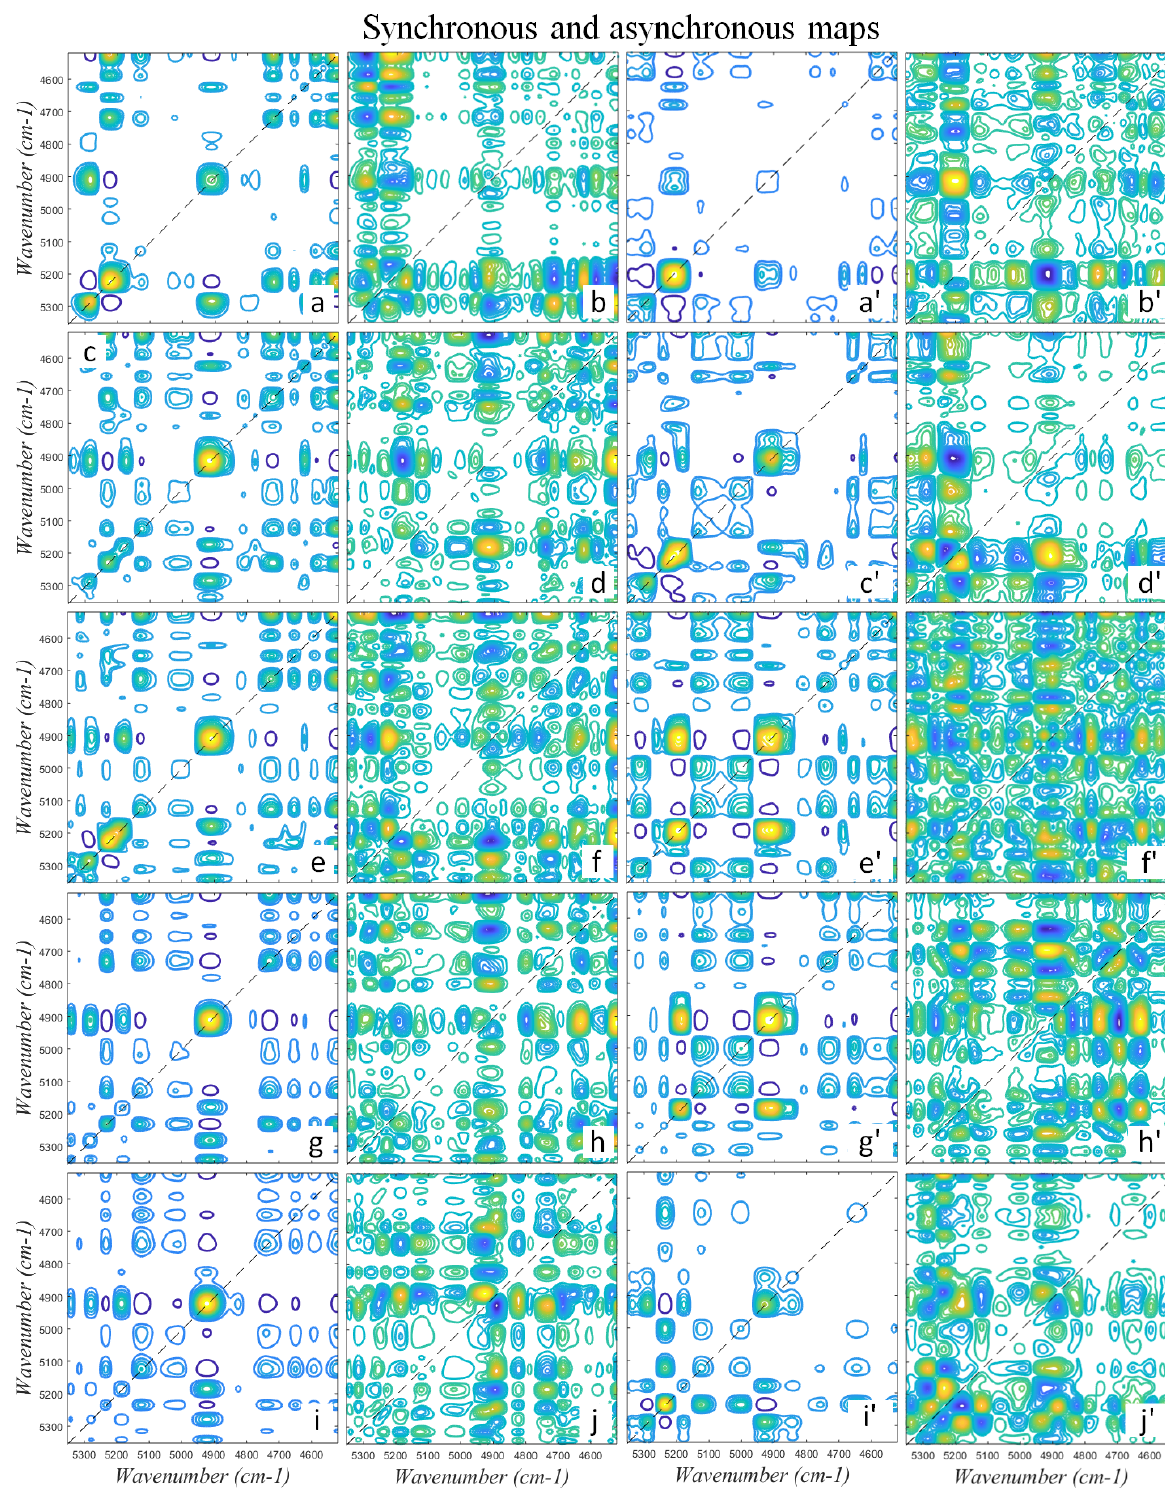
Figure 3. Synchronous ( a , c , e , g , i ) and asynchronous ( b , d , f , h , j ) maps of the spectra of the non-extracted ( a – j ) and water- extracted ( a ′ – j ′ ) reference ( a , b ) and hydrothermal treated wood samples at 35 ( c , d ), 60 ( e , f ), 80 ( g , h ) and 91 ( i , j ) %RH.